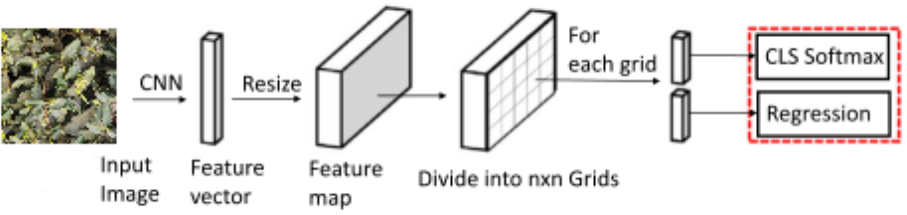
Figure 7. YOLO network structure.